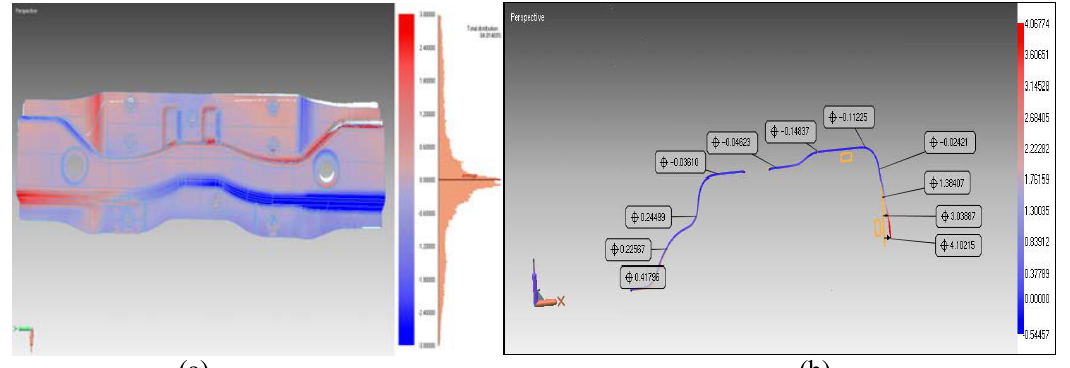
Figure 10. (a) Color Comparison Chart of As-Built Model to CAD surface Model, (b) The differences between scanned STL data and CAD data of a cross-section from any Y